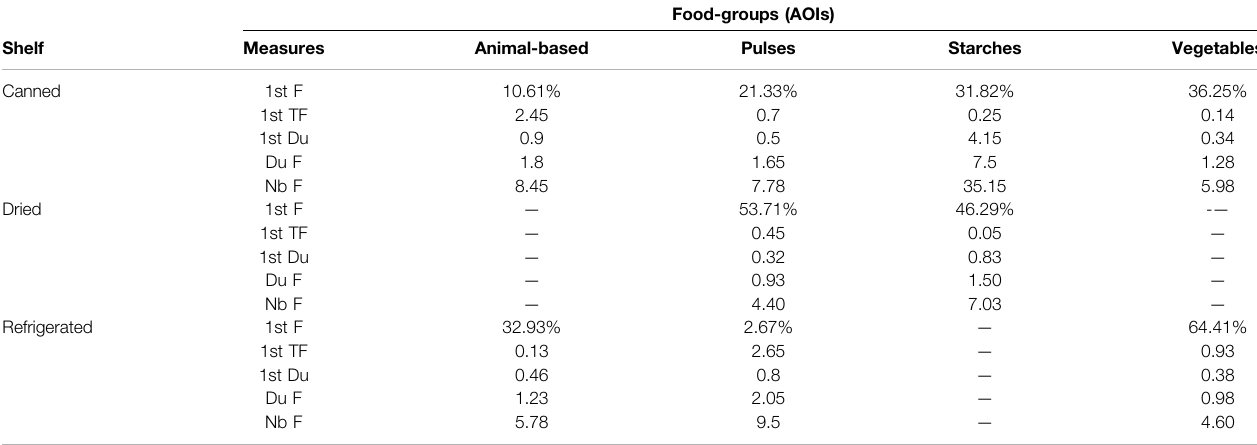
TABLE 4 | Gaze behavior in seconds converted into ratios (eye-tracking measures) of consumers toward each AOI (food-group) in the screening for the canned, dried, and refrigerated shelves. First fi xation (1st F, in %), Time to First Fixation (1st TF, in sec), First Fixation Duration (1st Du, in sec), and Number of fi xations